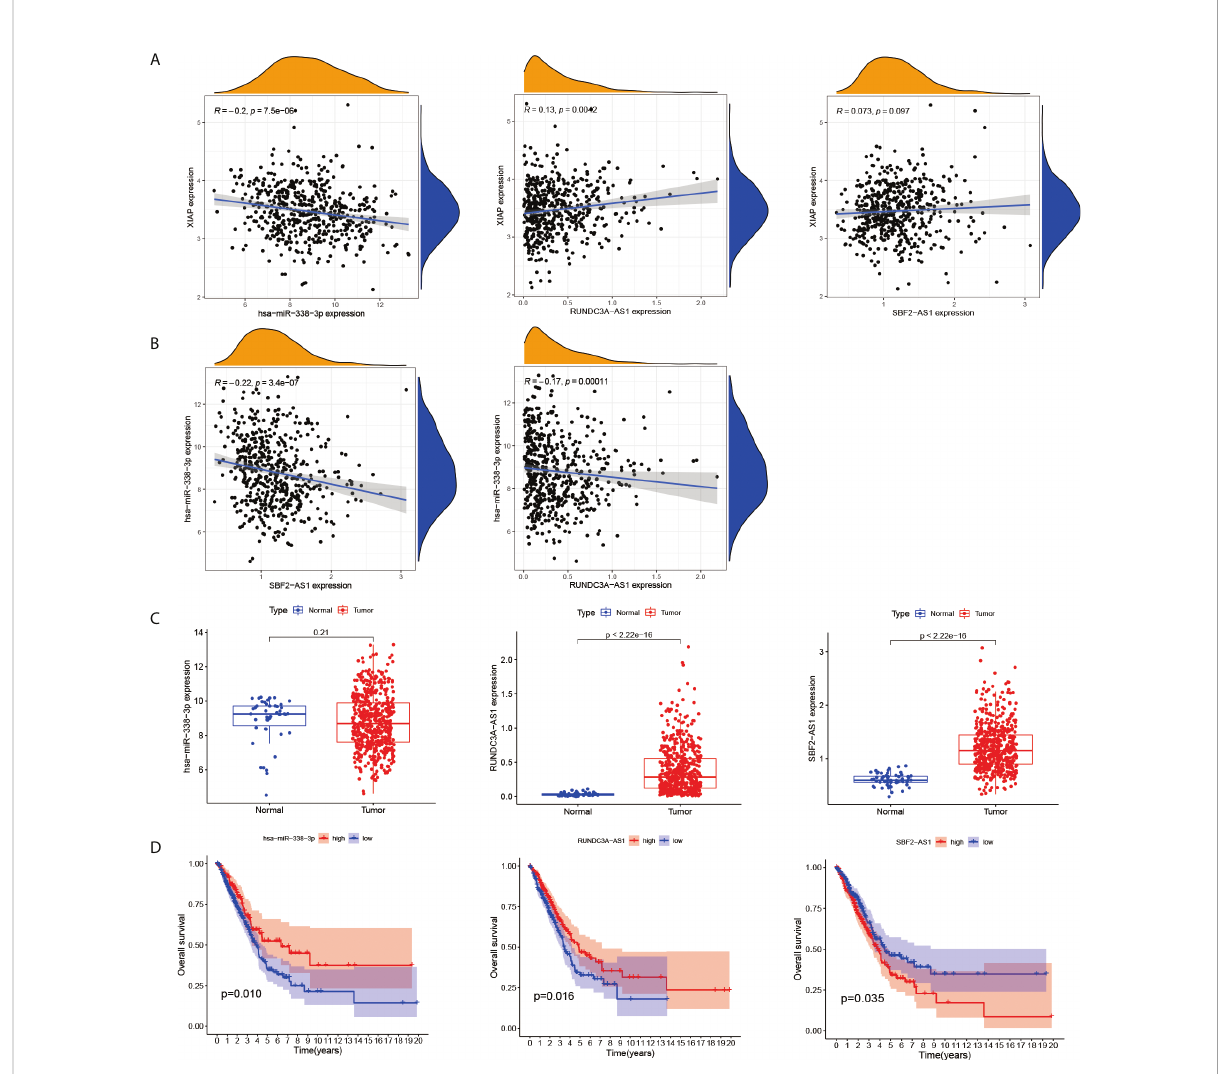
FIGURE 6 The correlation of XIAP, has-miR338-3p, SBF2-AS1 and RUNDC3A-AS1. (A) SBF2-AS1 and RUNDC3A-AS1 were positively associated with XIAP, and hsa-miR338-3p was negatively. (B) The relationship of SBF2-AS1or RUNDC3A-AS1 with hsa-miR338-3p. (C) The expression of has-miR338- 3p, SBF2-AS1 and RUNDC3A-AS1 in LUAD and normal tissues. (D) The relationship of has-miR338-3p, SBF2-AS1 and RUNDC3A-AS1 and OS, P < 0.05 indicated signi fi cant